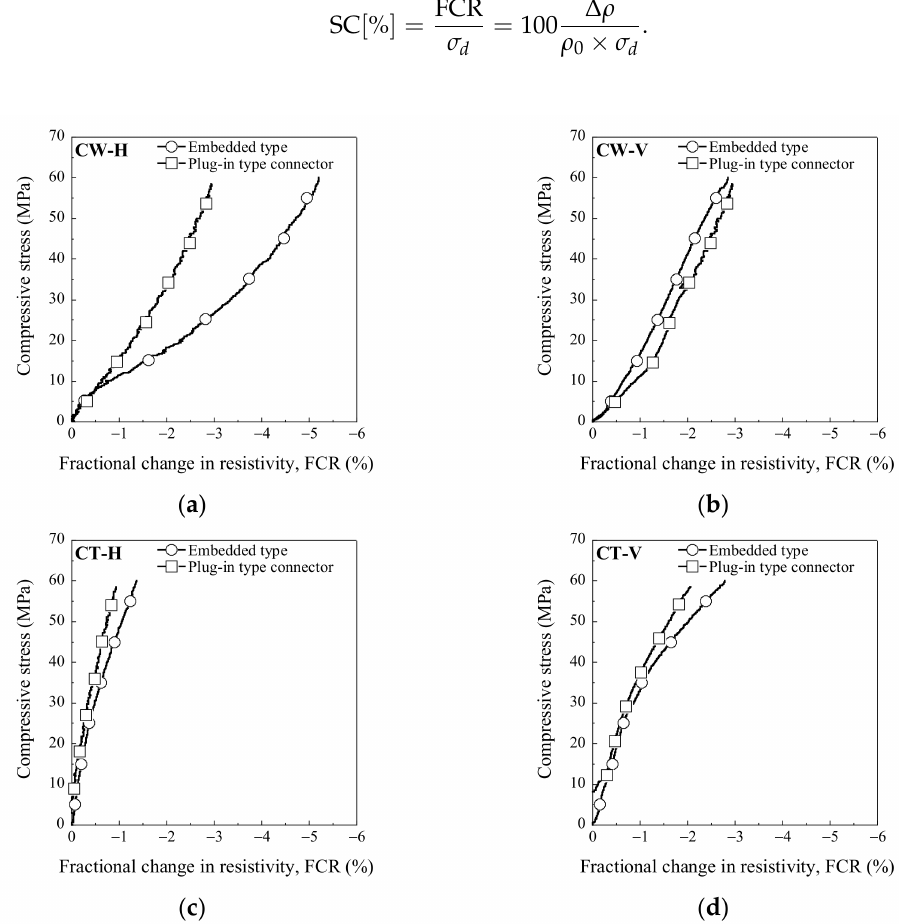
Figure 10. The electro-mechanical response of SCAs under compressive stress: ( a ) CW-H; ( b ) CW-V; ( c ) CT-H; ( d )